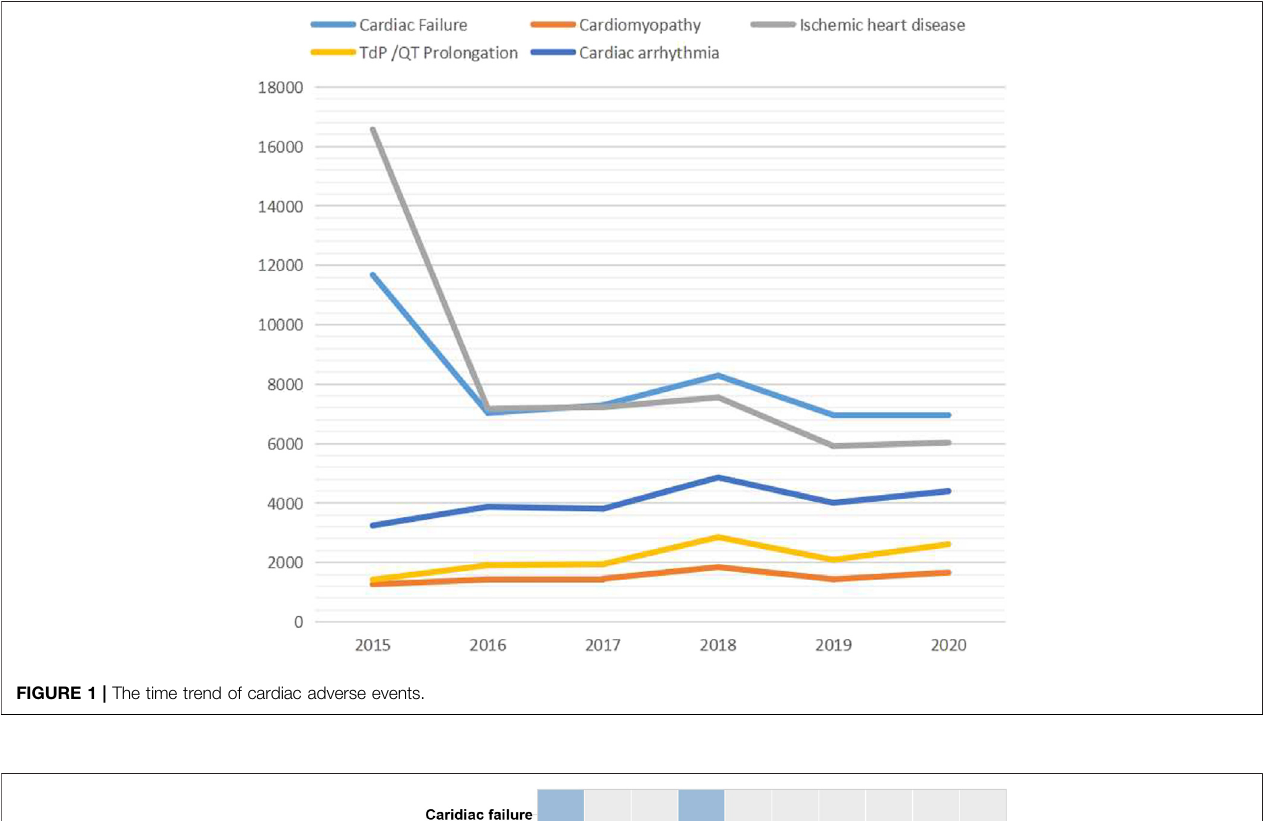
FIGURE 1 | The time trend of cardiac adverse events.